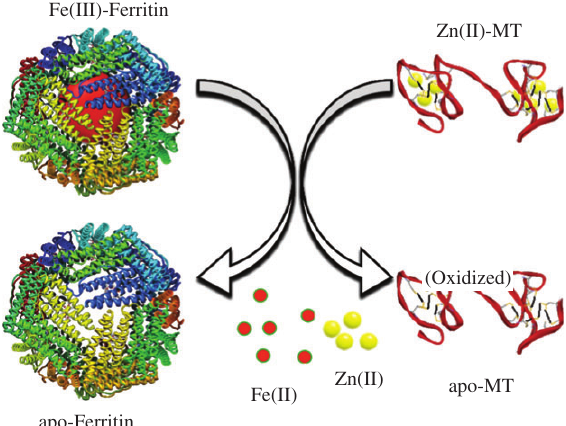
Figure 5 Schematic representation of the consequences of the interaction between iron-loaded ferritin and zinc-loaded mammalian MT1, MT2, and MT3 metallothionein